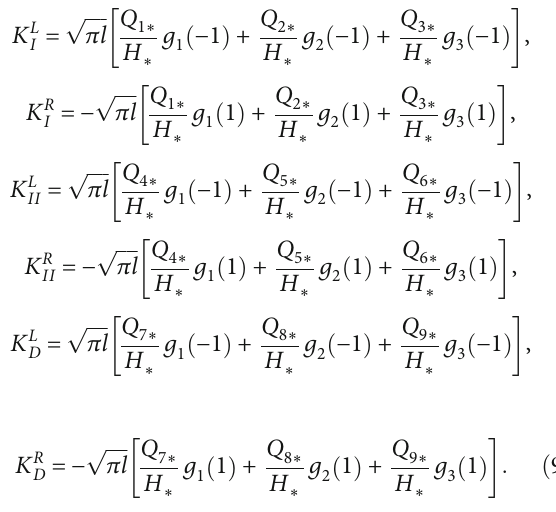
Figure 2: E ff ects of ð h di ff erent strip